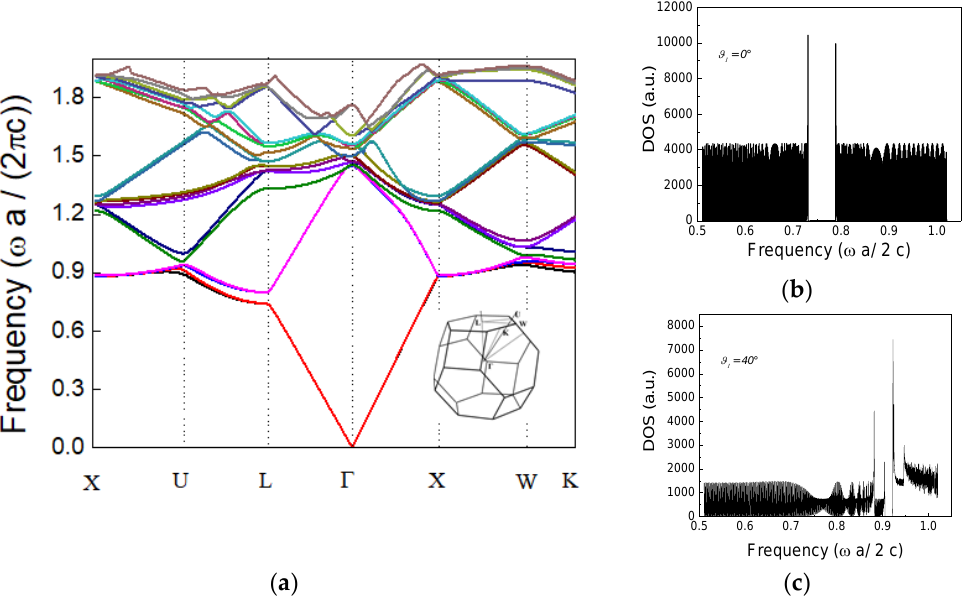
Figure 5. ( a ) Calculated band structure of the silica inverse opal. The inset is the reduced Brillouin zone. ( b , c ) Calculated DOS of inverse silica opal constituted by hollow spheres of about 370 nm at ϑ i =0° and ϑ i =40° to the direction Г-L, respectively.